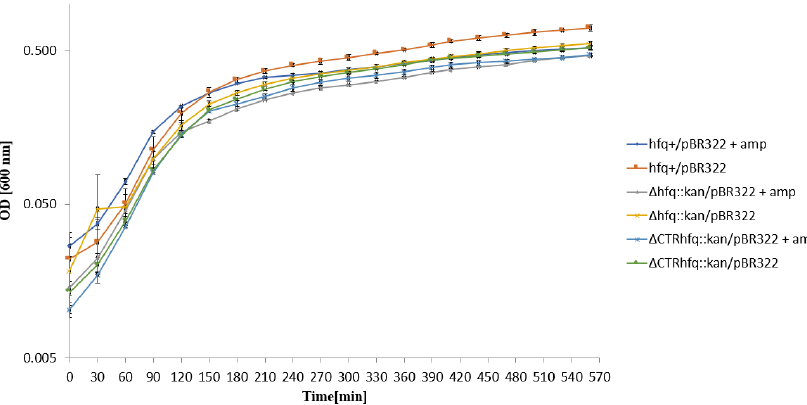
Figure 8. Growth of E. coli strains hfq + , ∆ hfq :: kan , and ∆ CTR hfq :: kan bearing plasmid pBR322 in the LB liquid medium containing 5 mg/mL ampicillin (+amp) or devoid of this antibiotic (no mark) at 37 °C, after transferring bacteria from antibiotic-free LB and diluting the culture 10 times in a fresh LB medium (with or without ampicillin) at time 0. The presented data indicate mean values from three independent experiments with error bars showing SD. Minimal inhibitory concentration (MIC) of ampicillin for hfq + , ∆ hfq :: kan , and ∆ CTR hfq :: kan hosts bearing pBR322 under these conditions was >2048 μ g/mL for each strain.